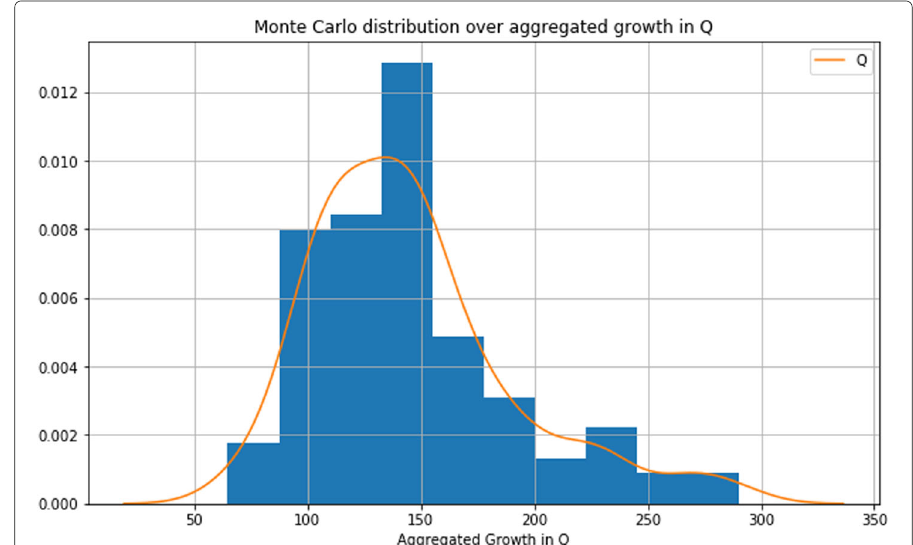
Fig. 6 Distribution of aggregated growth in Q over 100 Monte Carlo Runs under step decay block reward schedule